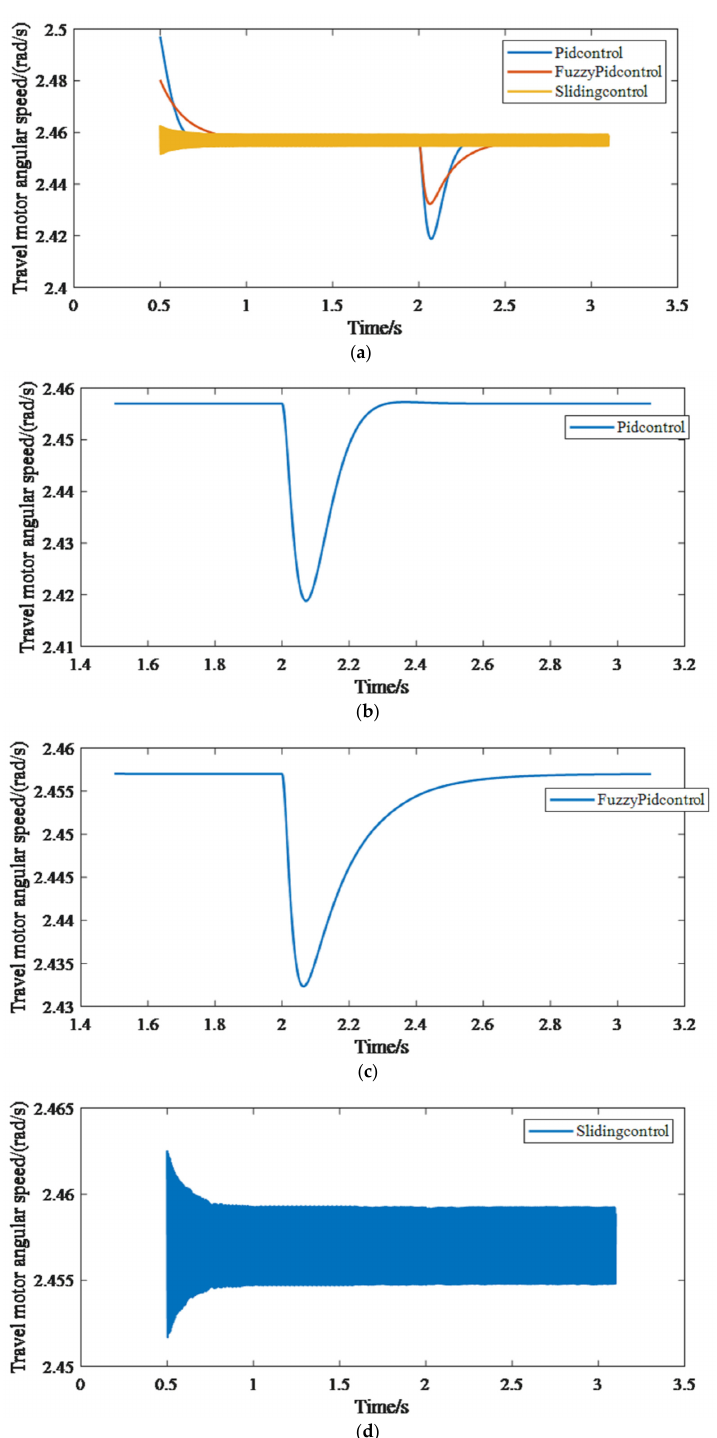
Figure 15. ( a ) Simulation results of the sudden crossing of the smooth state of the travel drive system with three control strategies. ( b ) Simulation result of the sudden crossing of the smooth state of the travel drive system with PID control strategy. ( c ) Simulation result of the sudden crossing of the smooth state of the travel drive system with adaptive fuzzy PID control strategy. ( d ) Simulation result of the sudden crossing of the smooth state of the travel drive system with sliding mode control strategy. Therefore, regardless of the sudden increase in load in the smooth running state of the travel motor, whether it was a sudden slope block obstacle or a ditch obstacle on a